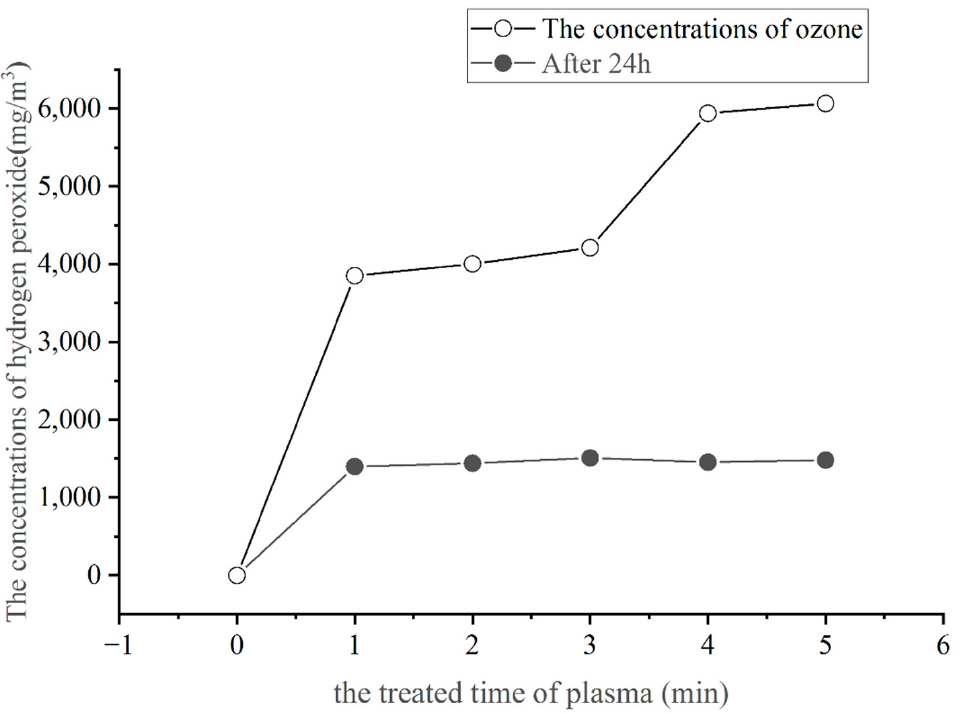
Figure 2. The quality of hydrogen peroxide produced by the